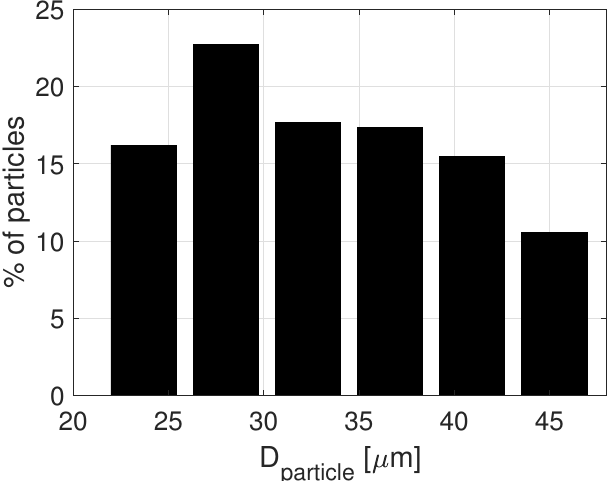
Figure 2. The particle size distribution of the uncycled, anhydrous sample